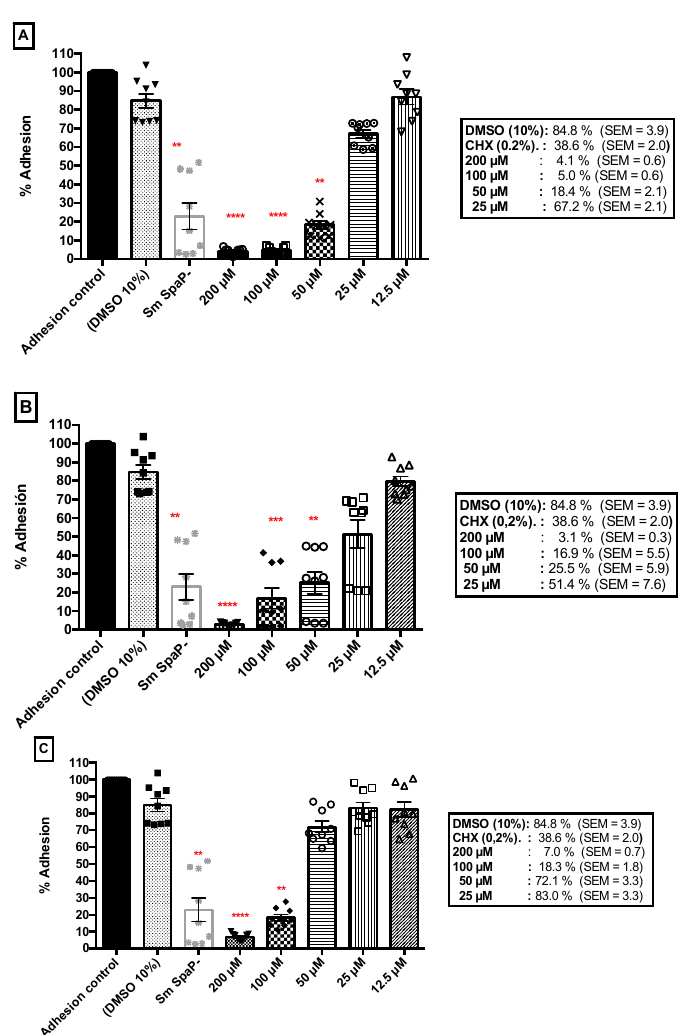
Figure 5. Surface adhesion of S. mutans -LT11 to a polystyrene microwell plate treated with molecules ( A ) ZI-187, ( B ) ZI-906 and ( C ) ZI-939. The asterisks represent the level of significance ** ( p ≤ 0.01), *** ( p ≤ 0.001) and **** ( p ≤ 0.0001). All experiments were performed in triplicate and reproduced three separate times (the geometric figures above each column chart indicates each data).